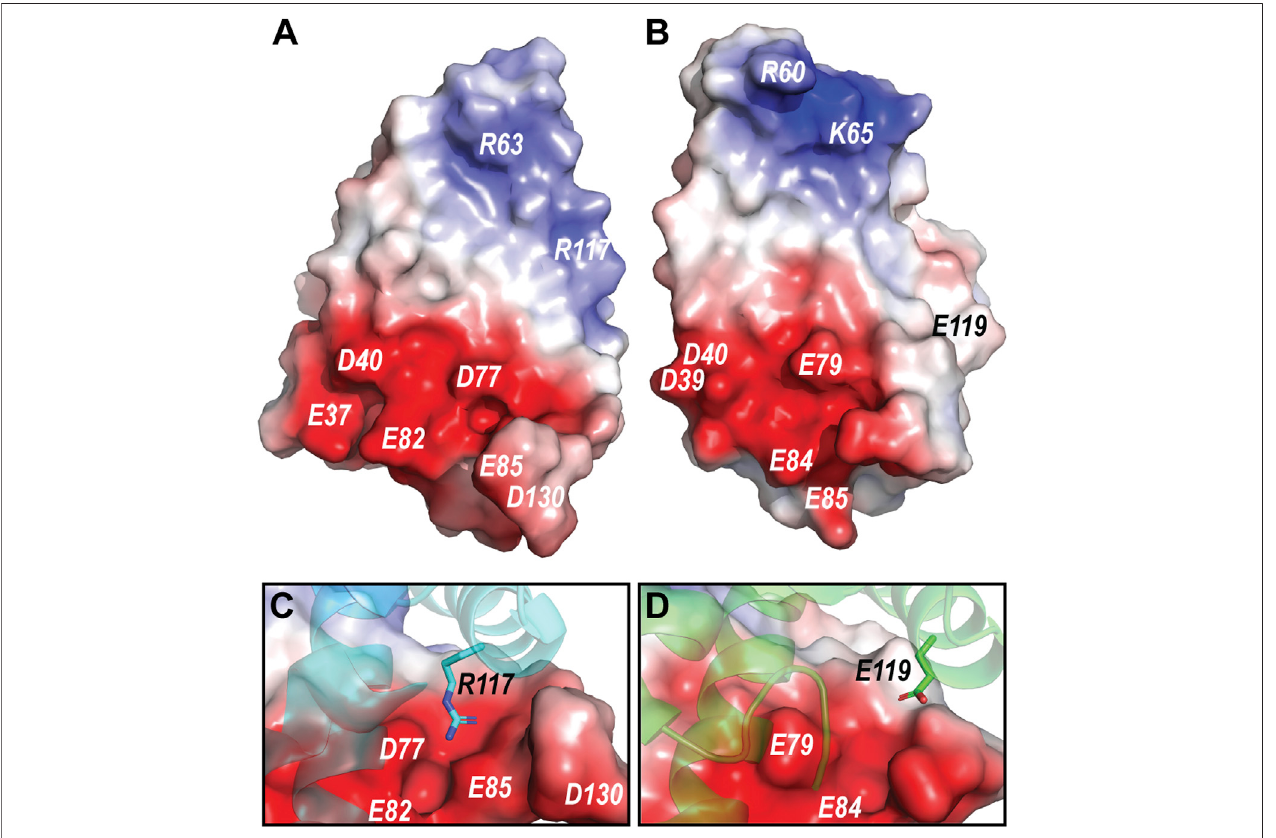
FIGURE7 |(A) Electrostatic potential of A. argentata TuSp NT dimer subunit. (B) Electrostatic potentialof E. australis MaSp NT(PDB ID 2LTH) dimer subunit. Red color indicates negative charges, and blue color indicates positive charges. The surface-exposed charged residues are labeled. (C) and (D) shows contact surfaces of the residues R117 and E119 from the opposite subunit at the TuSp NT and MaSp NT dimer interfaces,